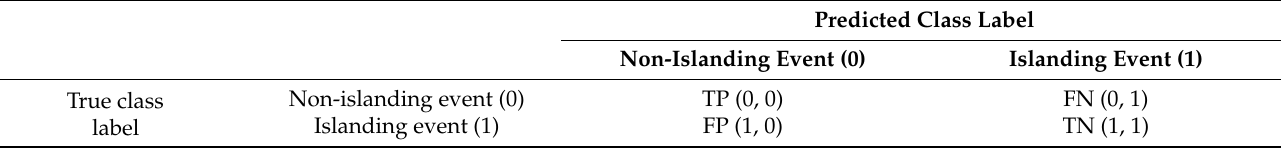
Table 4. Confusion table used in this